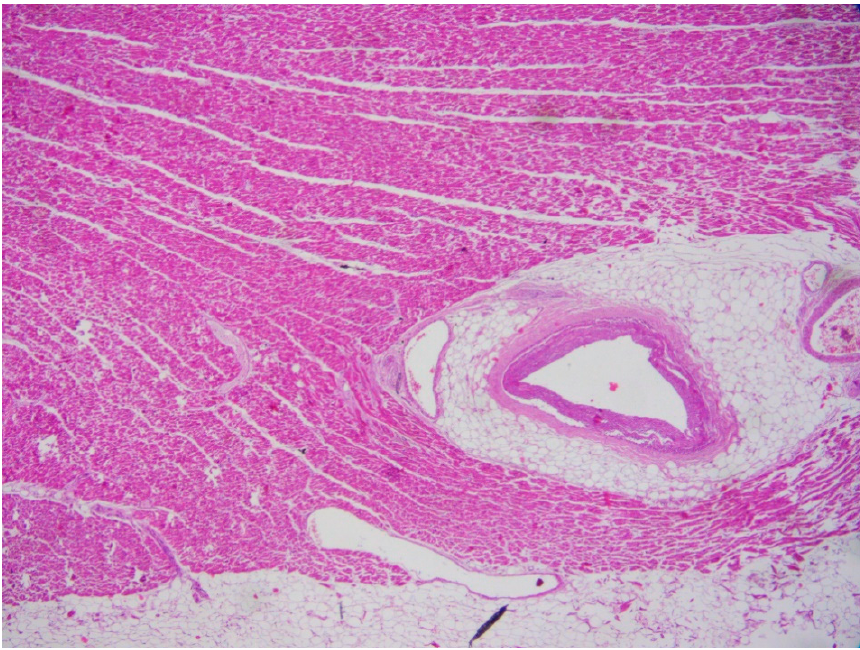
Figure 3. Myocardial bridging in the heart of a 32-year-old man who suddenly died (Hematoxylin and eosin stain, 20× magnification).